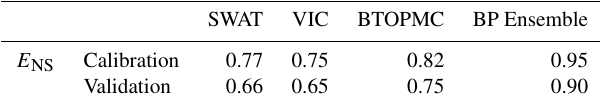
Figure 2. The topology of the BPNN model. Table 5. Comparison between ensemble simulation and ensemble members’ optimal simulating series.